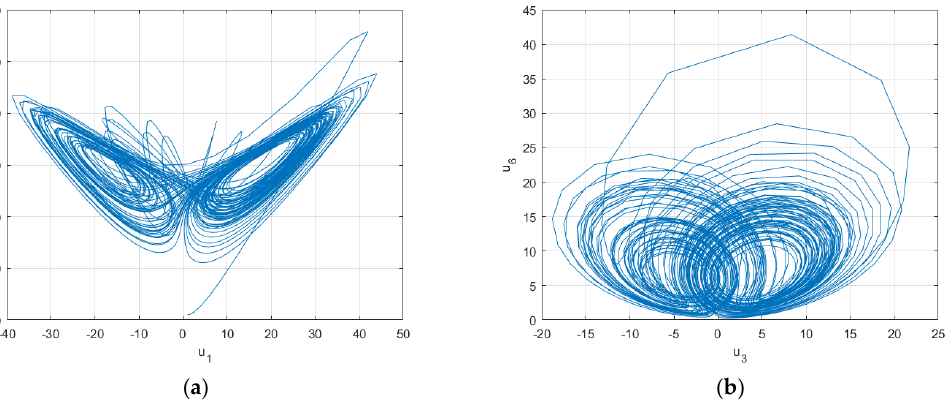
Figure 5. Attractor phase diagram of system (11). ( a ) 𝑢 1 − 𝑢 5 phase diagram of system (11); ( b ) 𝑢 3 − 𝑢 6 phase diagram of system